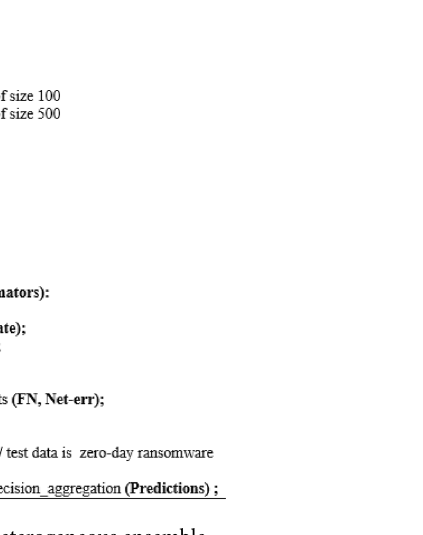
Figure 5. Algorithm 1: Creating deep heterogeneous